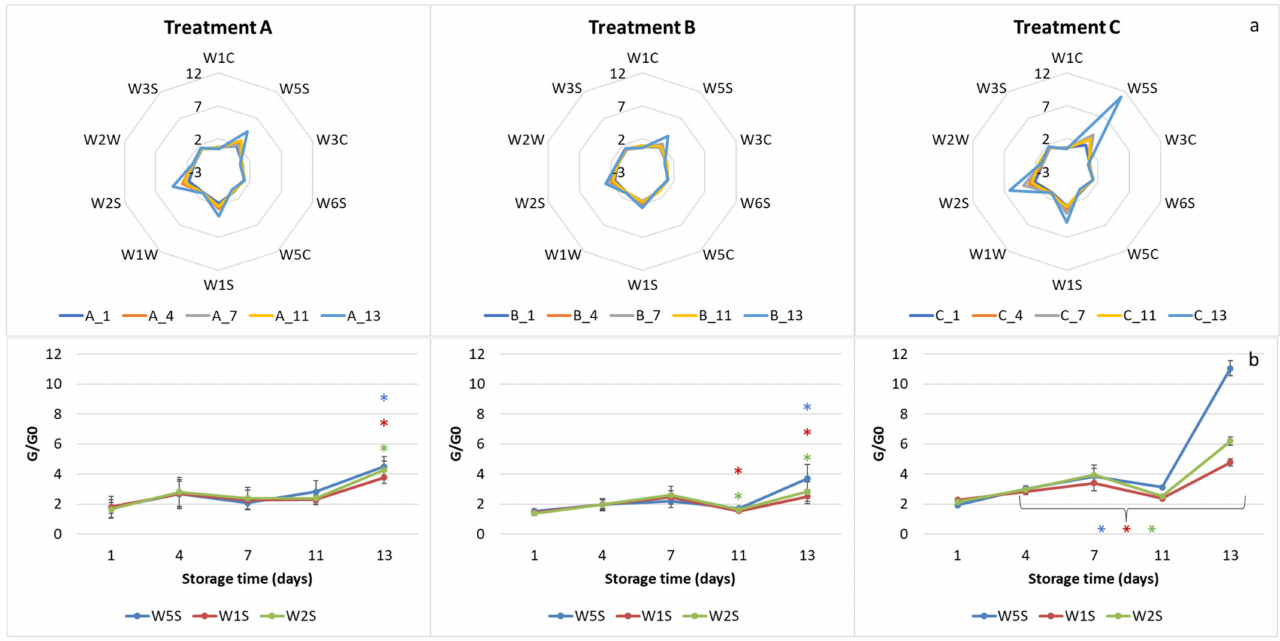
Figure 2. E- nose profiles ( a ) and trend curves of W5S, W1S and W2S sensors ( b ) of the three treatments during the storage: Trial 2. Data are reported as mean values ± standard deviation. Colored asterisks indicate significant differences in the corresponding sensor signals according to ANOVA and Tukey’s post hoc test ( p <